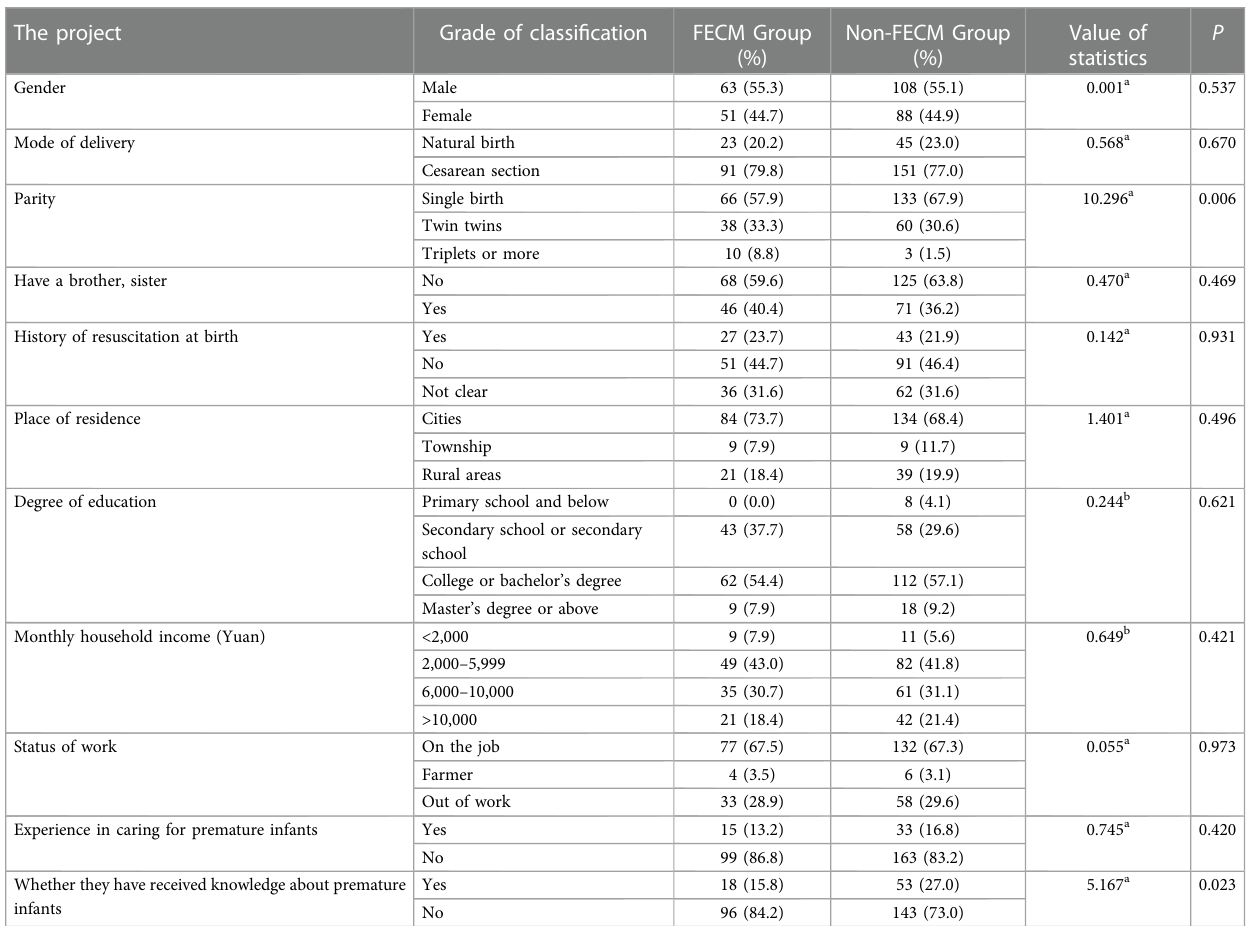
TABLE 1 Comparison of general information. The project